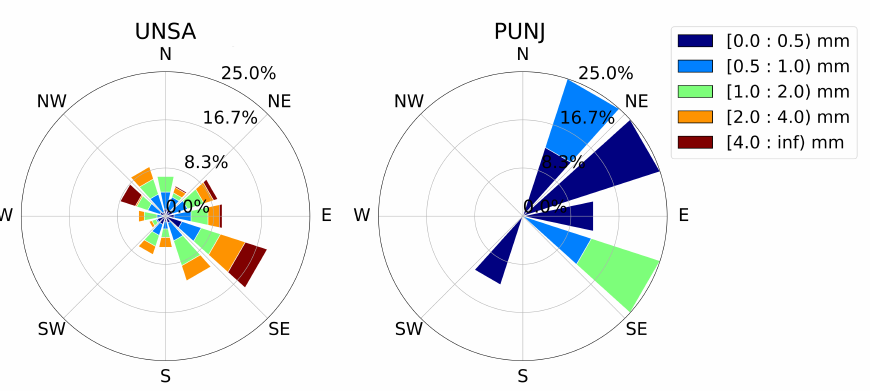
Figure 14. Summer season wet gradients for the larger than the 75th percentile rainfall events for the UNSA and PUNJ stations. The seasonal and azimuthal segmentation coincides with Figures 11–13, and the rainfall events are identified by the cumulative rainfall on 1 h basis that is measured with in situ rain